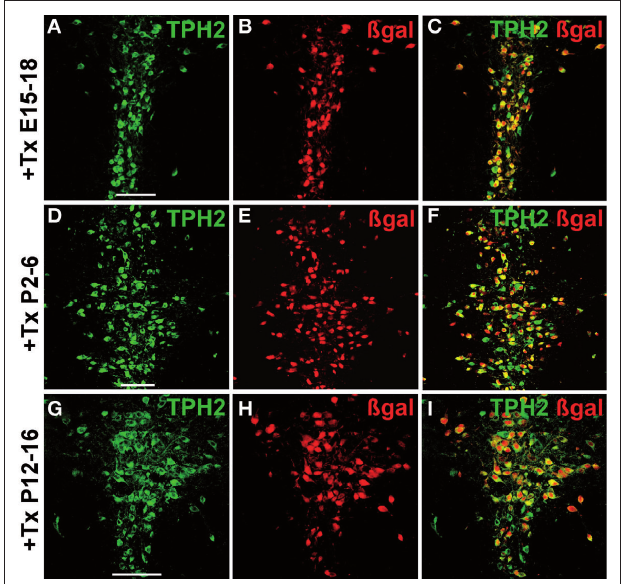
FIGURE 4 | Inducible recombination in serotonergic neurons of embryonal and postnatal R26R TPH2-CreERT2 mice. Pregnant or lactating mothers of line 1.38 were injected with tamoxifen ( + Tx). (A–C) One milligram twice daily at E15–18; (D–F) 1 mg twice daily at P2-6; (G–I) 3 mg twice daily at P12-16. Transgenic R26R TPH2-CreERT2 offspring were sacrifi ced at P60 and analyzed with dual-label fl uorescence immunohistochemistry for TPH2 and β -gal. Colocalization is visualized at the level of dorsal raphe nuclei using confocal images. (A,D,G) TPH2 fl uorescence; (B,E,H) β -gal fl uorescence; (C,F,I) merged images. Frequent colocalization of β -gal and TPH2 confi rms effi cient recombination during embryogenesis (C) and early (F) and later (I) postnatal development. Scale bars: 100